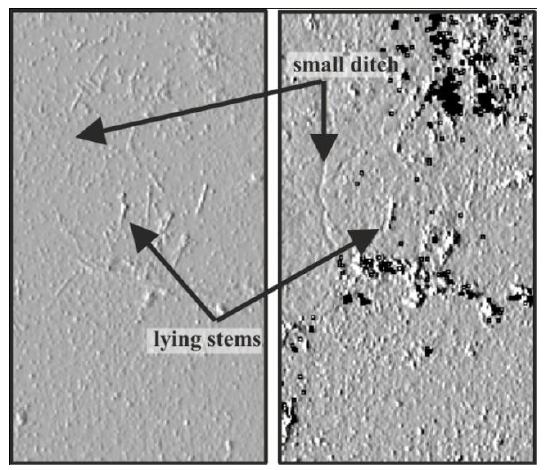
Figure 8. Shading of the geometry-based roughness (left) and of the mean echo widths (right); d < 0.5 m. Black areas are ‘no data’ raster z